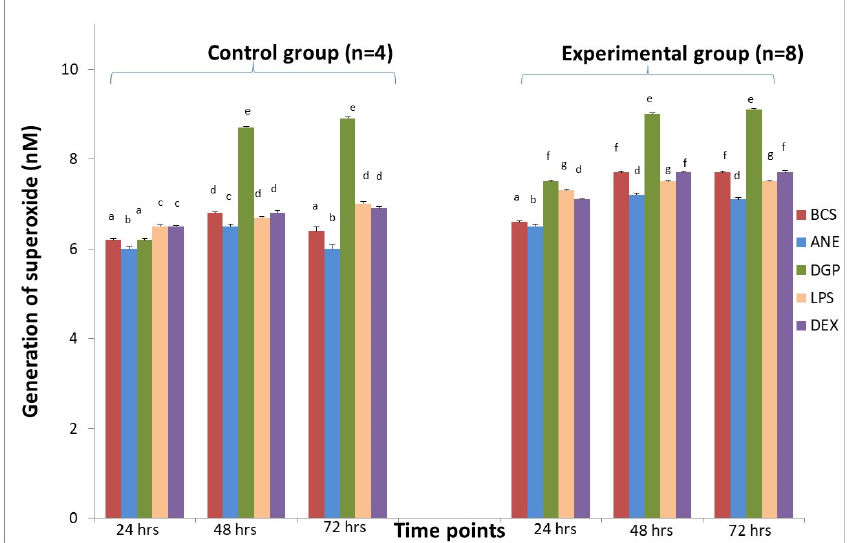
Figure 6. The effect of different stimulators on superoxide generation by macrophages derived from sheep in the control group ( n = 4) and in the experimental group ( n = 8) during insertion of Ti implant into the tibia. BCS—macrophages stimulated only with bovine calf serum, ANE—antimicrobial neutrophil extract, DGP—neutrophil degranulation product, LPS—lipopolysaccharide, DEX—dexamethasone. Values are mean ± SE obtained from each separate experiment conducted in both groups of sheep. There are significant differences between mean values marked with different letters ( p < 0.05) compared to BCS group in each time